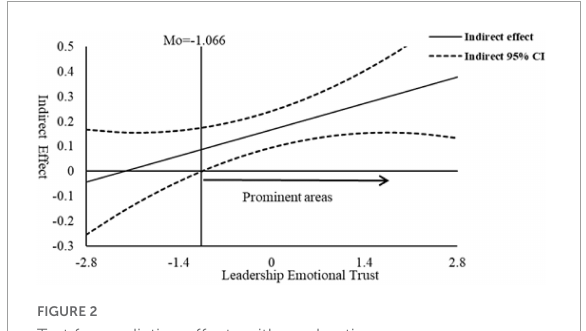
FIGURE2 Test for mediating effects with